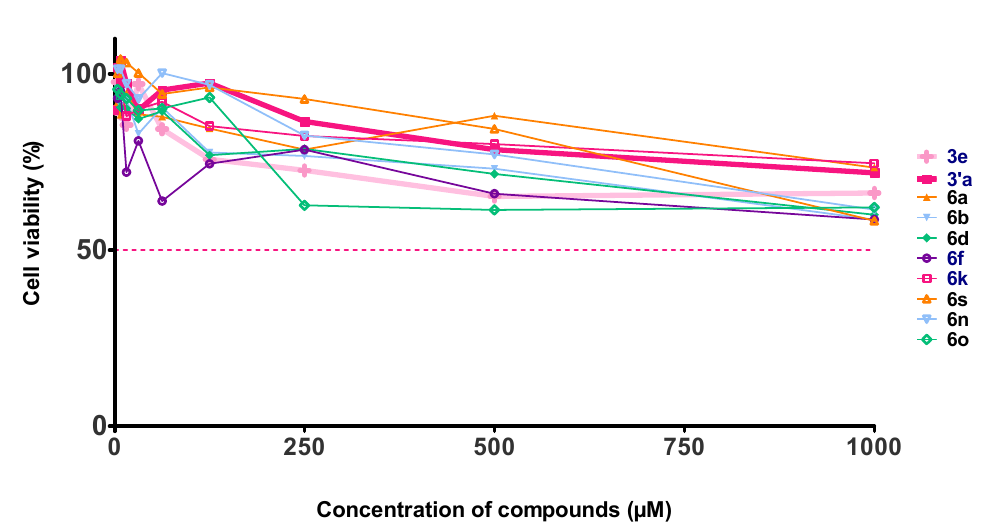
Figure 5. Cytotoxic activity on Vero cells of the 10 most active chromone carboxamides, expressed as viability % (GraphPad 5.0).